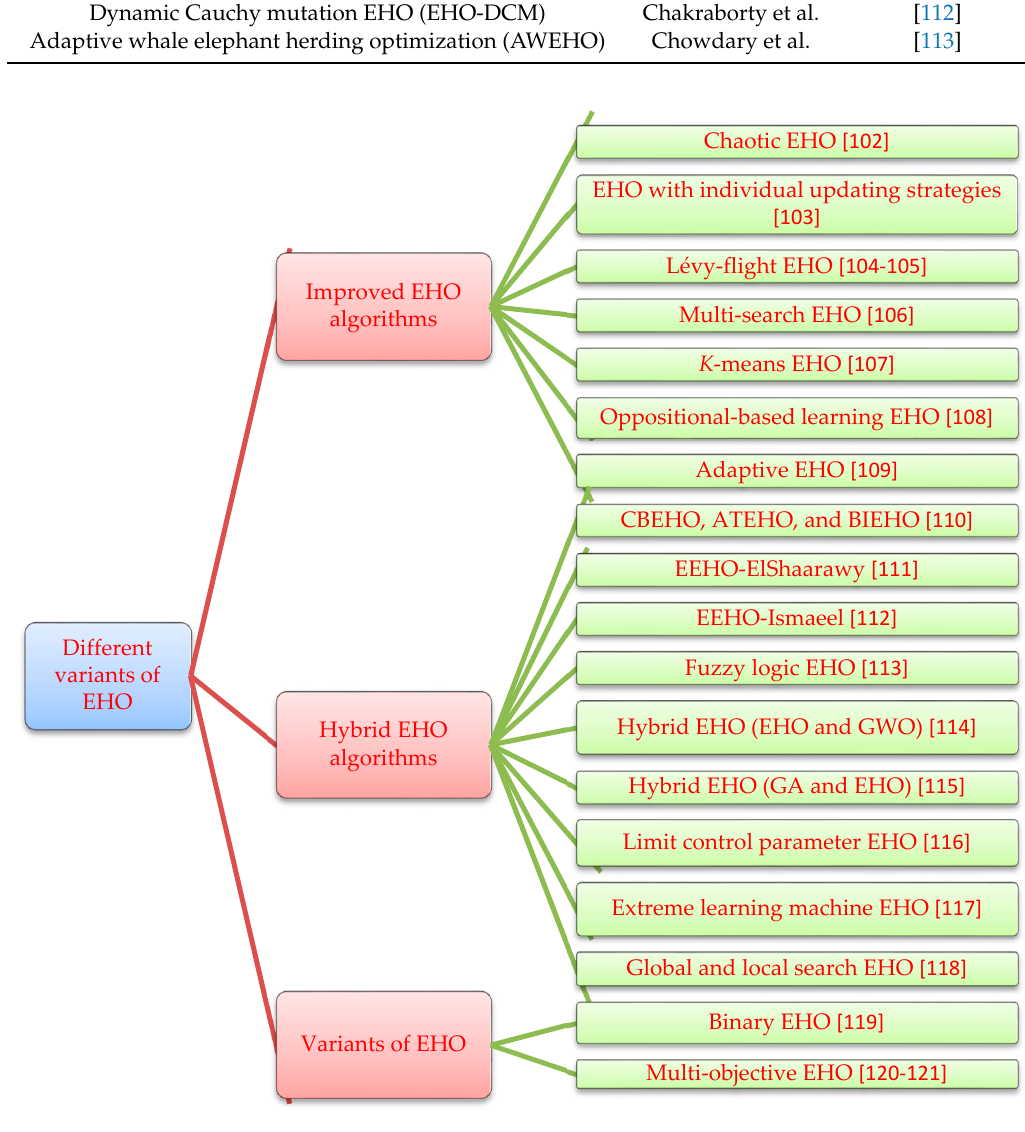
Figure 4. Di ff erent variants of Figure 4. Different variants of EHO. Table 1. The improved EHO algorithms .